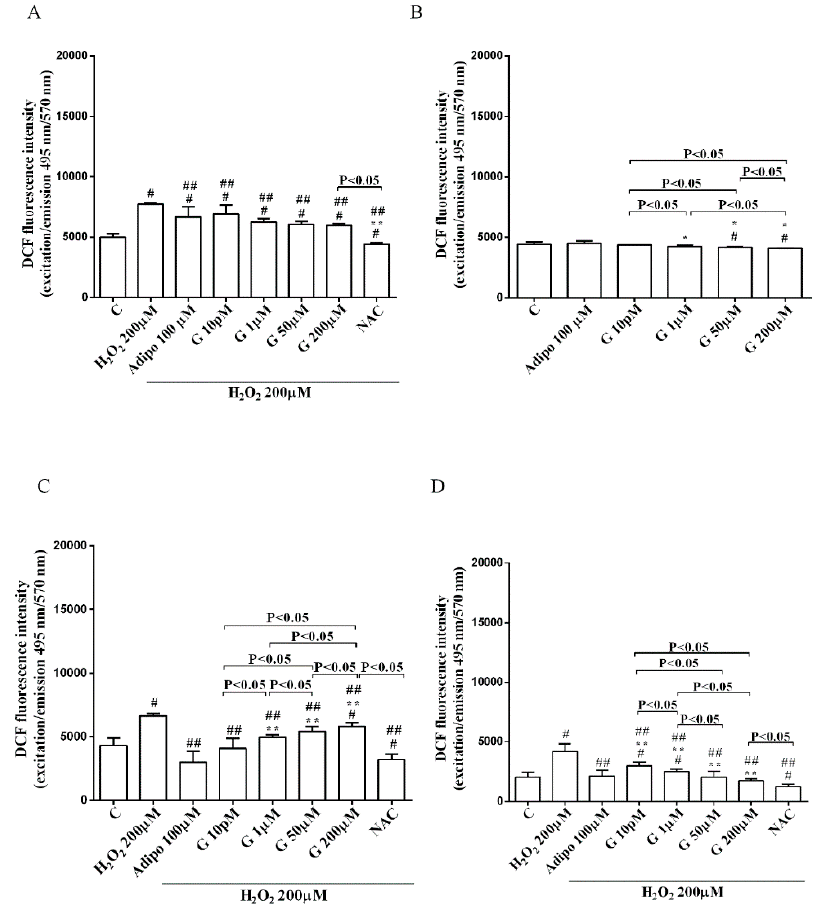
Figure 6. Effects of genistein on ROS production in pre-adipocytes, cultured in peroxidative ( A ) and physiological ( B ) conditions, and in white ( C ) and brown ( D ) adipocytes. Abbreviations are as in